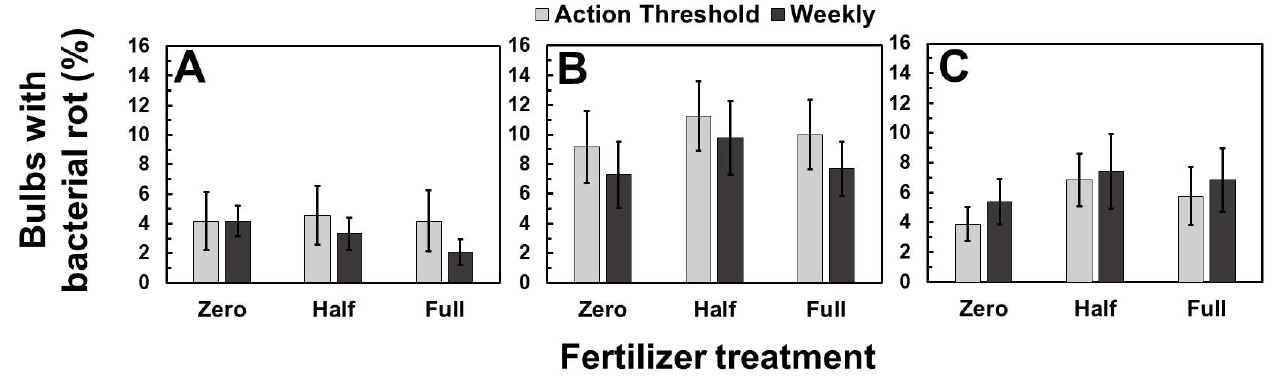
Figure 4. Mean ( ± SEM) percent bulbs with symptoms of bacterial bulb rot in each fertilizer rate and insecticide program combination in 2019 ( A ), 2020 ( B ), and 2021 ( C ). There were no significant differences among treatments within each year (Tukey’s HSD, p > 0.05).